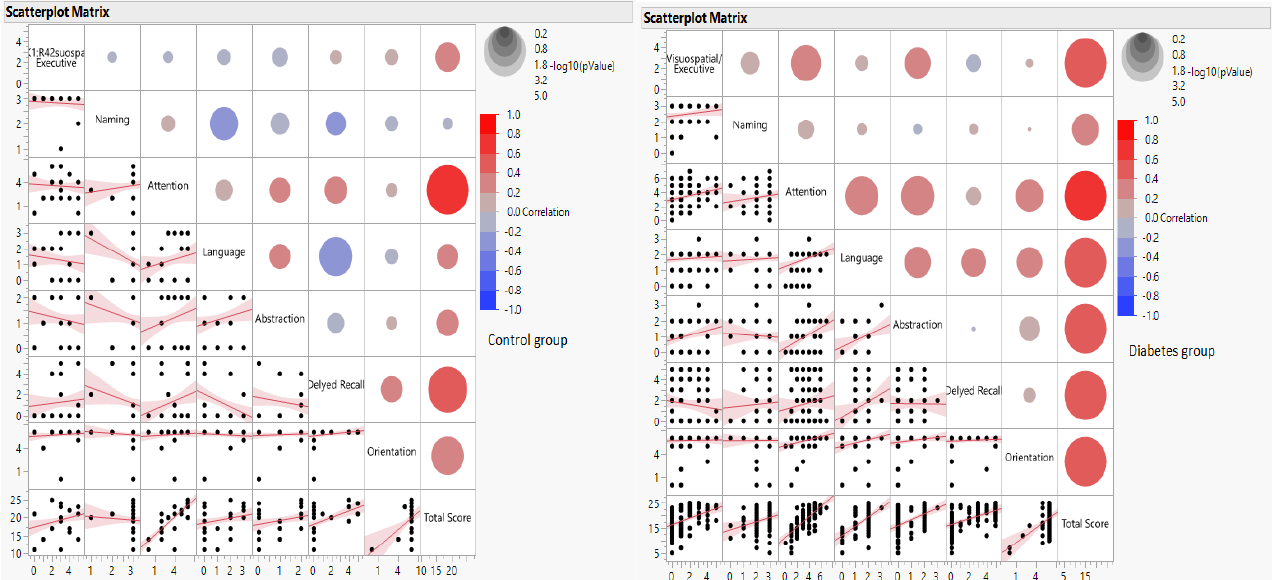
Figure 2. Scatter plot and bubble distribution of multivariate correlation analysis.